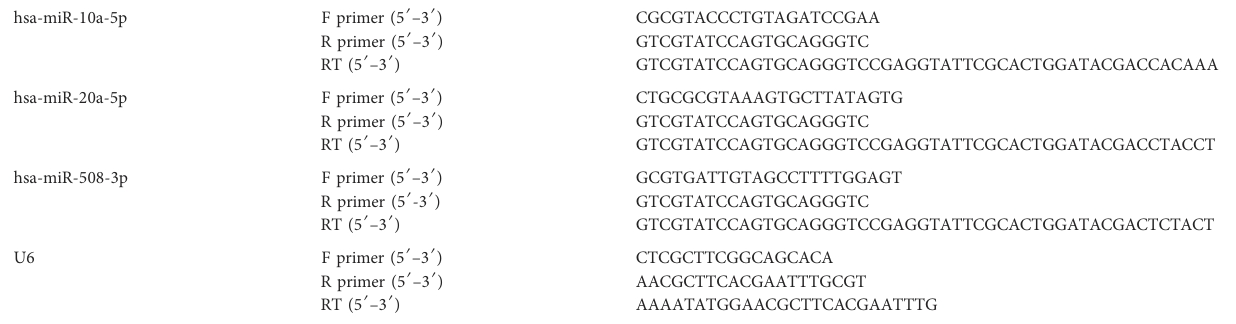
TABLE 1 Primer sequences of hsa-miR-10a-5p, hsa-miR-20a-5p, and hsa-miR-508-3p.